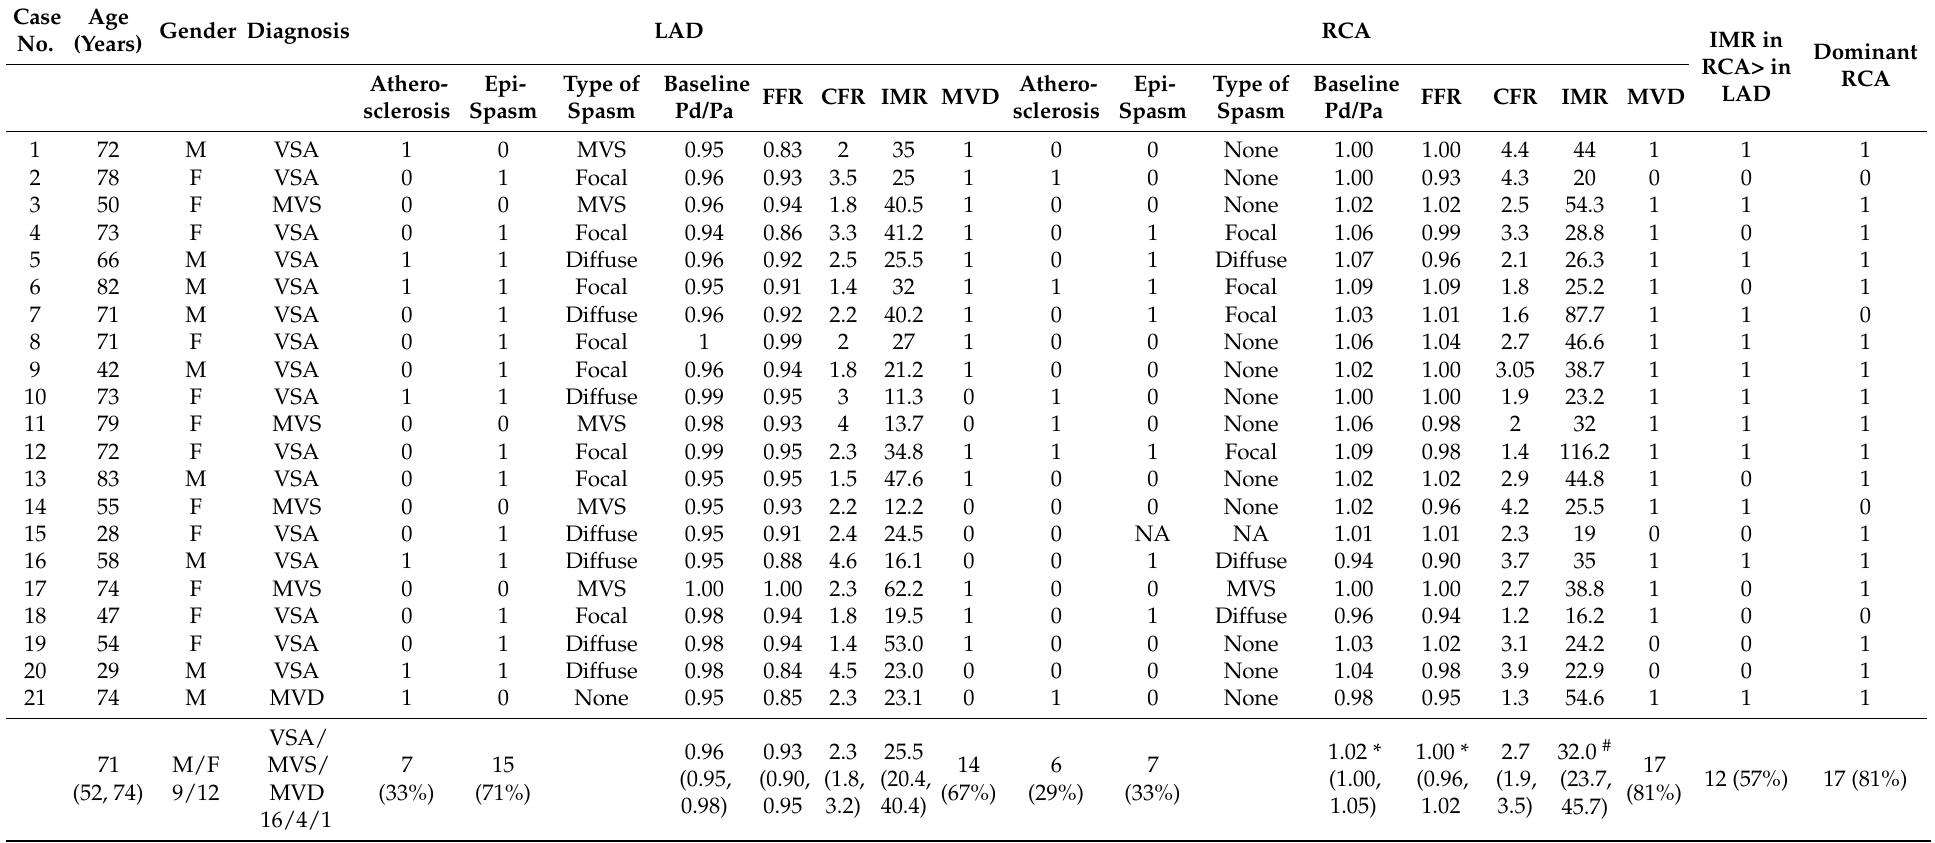
Table 4. Data in patients who performed MVFT in both LAD and